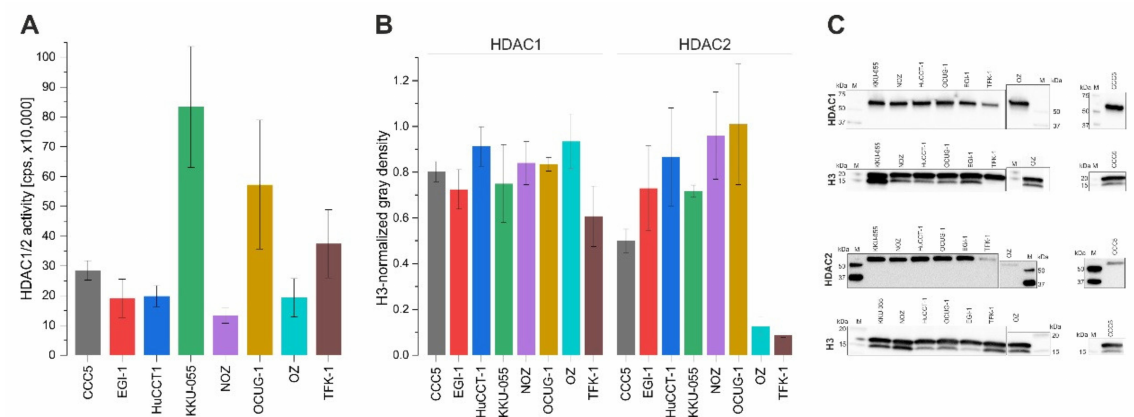
Figure 3. HDAC 1/2 activity and protein expression in BTC cells. ( A ) HDAC activity was measured using an HDAC-Glo I/II Assay and Screening System (Promega). ( B ) Quantification of HDAC 1 and HDAC 2 protein levels in BTC cells. ( C ) Representative Western blot images, cropped. The protein of interest and reference protein were run and processed on separate gels and membranes. For original uncropped blots see Figure S11. Data are presented as mean value ± SEM of n = 3 or n = 4 (HDAC1 protein expression) individual biological replicates. Abbreviations: BTC, biliary tract